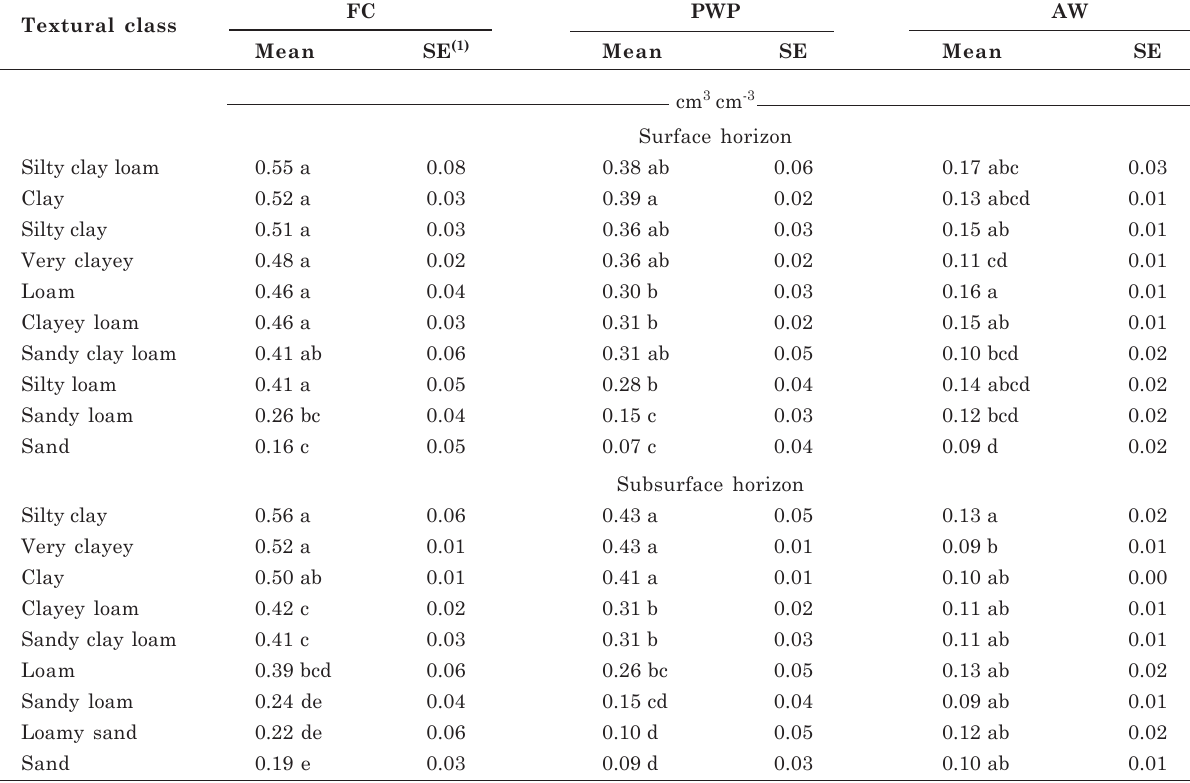
(1) SE: standard error. Lower case letters compare the classes in each horizon by the LSD test